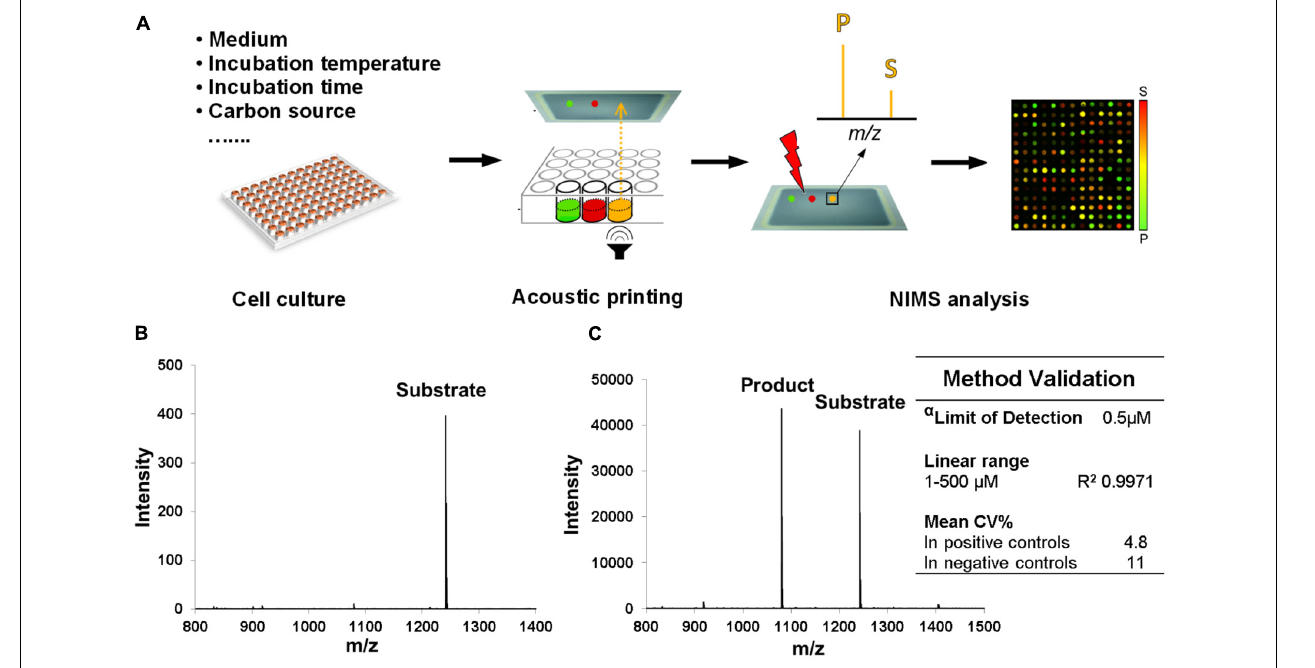
500 fmoles), which is the limit of quantification (LOQ) in this method (S/N ratio > 10). (C) Spectrum of an assay mixture that produced 55% conversion. The lowest concentration of substrate ( α ) is detected with S/N ratio > 5 in this assay.The low coefficient of variance (CV) we found to be <